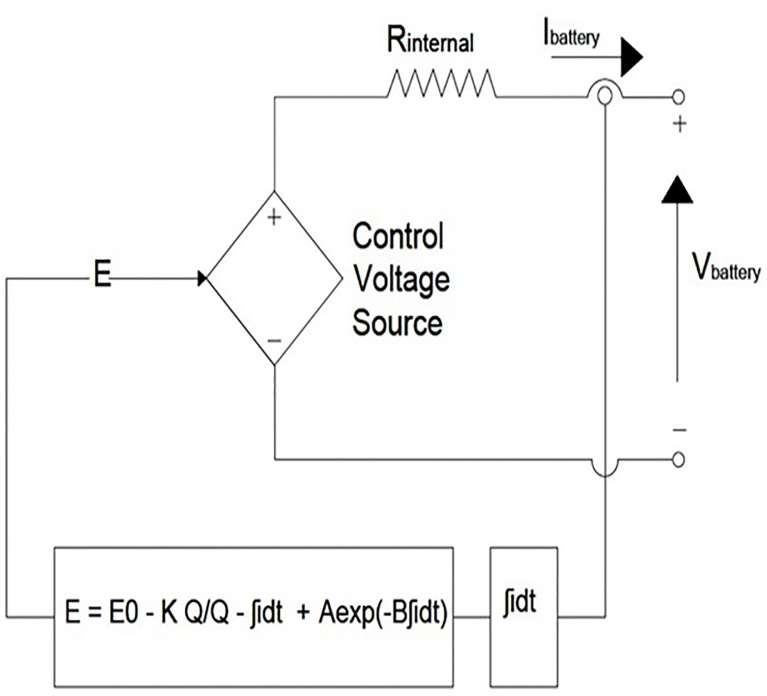
Non-linear typical battery model [36].